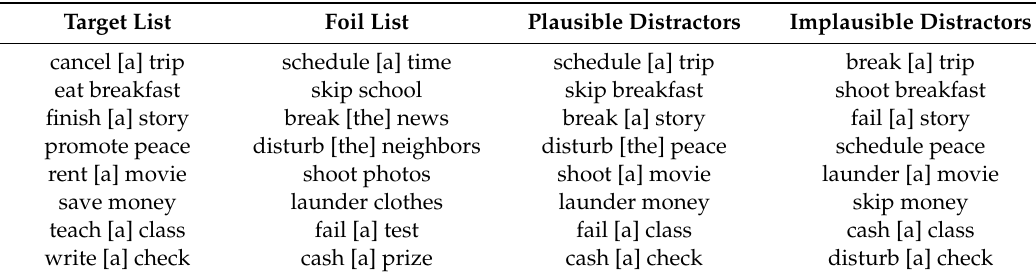
Table 2. List of verb–noun phrases per